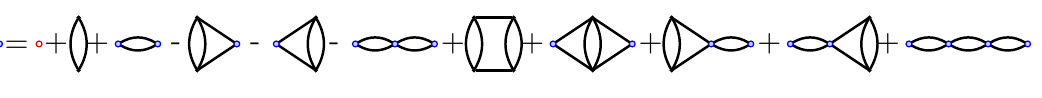
Figure 9 . Some double caps.